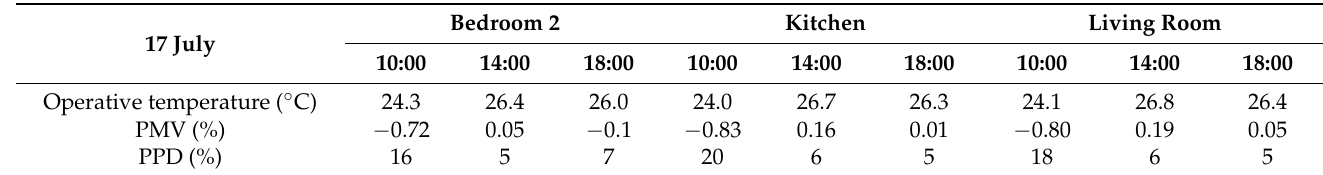
Table 8. PMV and PPD values calculated on 17 July.